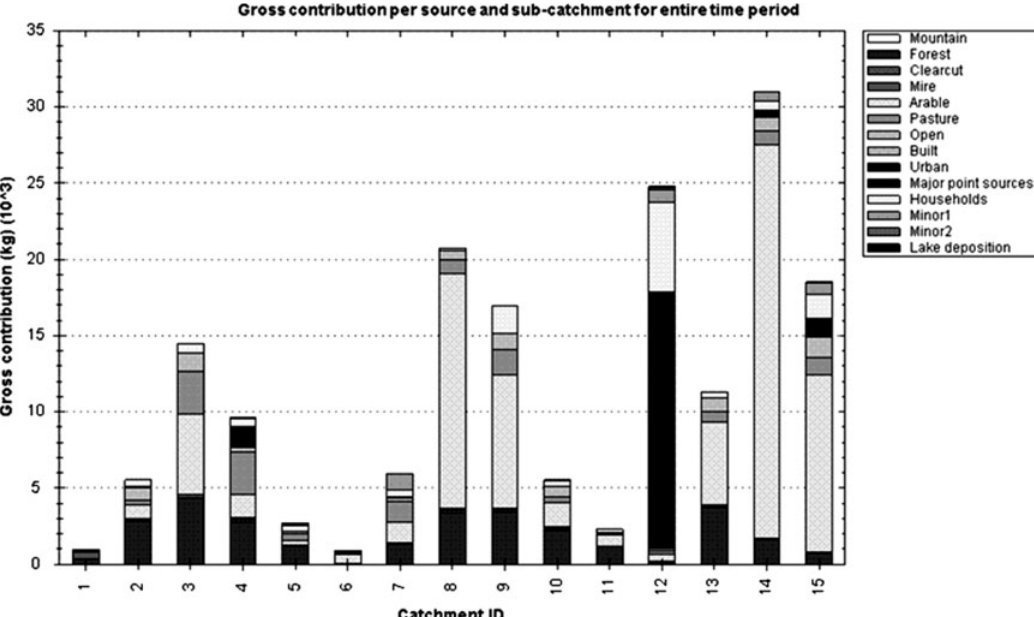
Fig. 9. P tot loads and source apportionment in Be¯rze River subcatchments (2000 (cid:2)